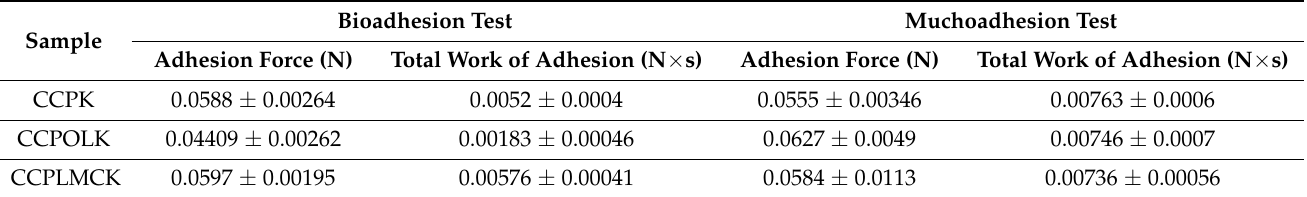
Table 3. Adhesive properties of the studied